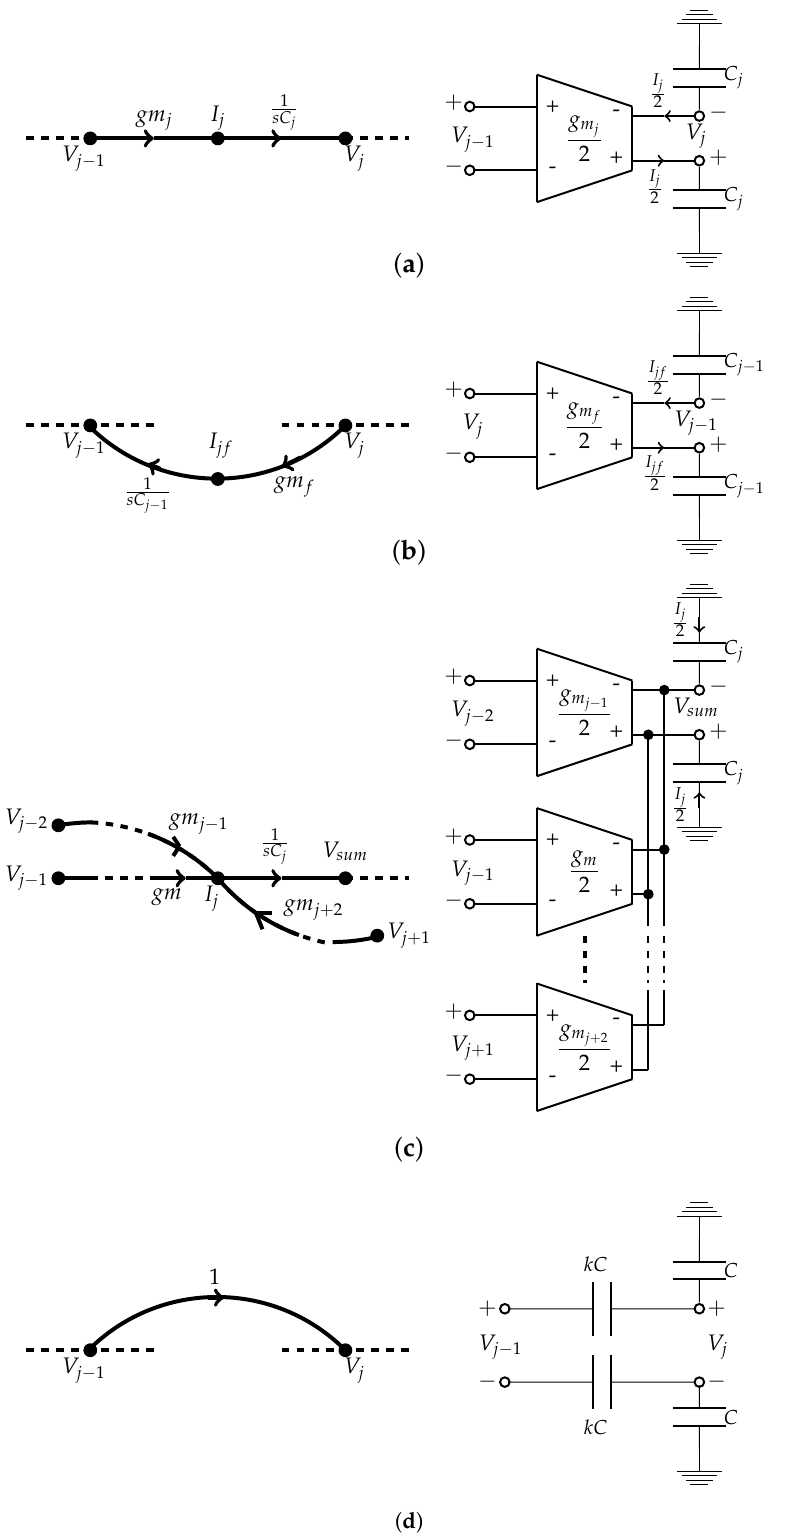
Figure 3. Fully differential building blocks: ( a ) integrators; ( b ) feedback twig between two nodes; ( c ) current addition at a node and its conversion to a voltage node; ( d ) a direct pathway with unity gain between two voltage